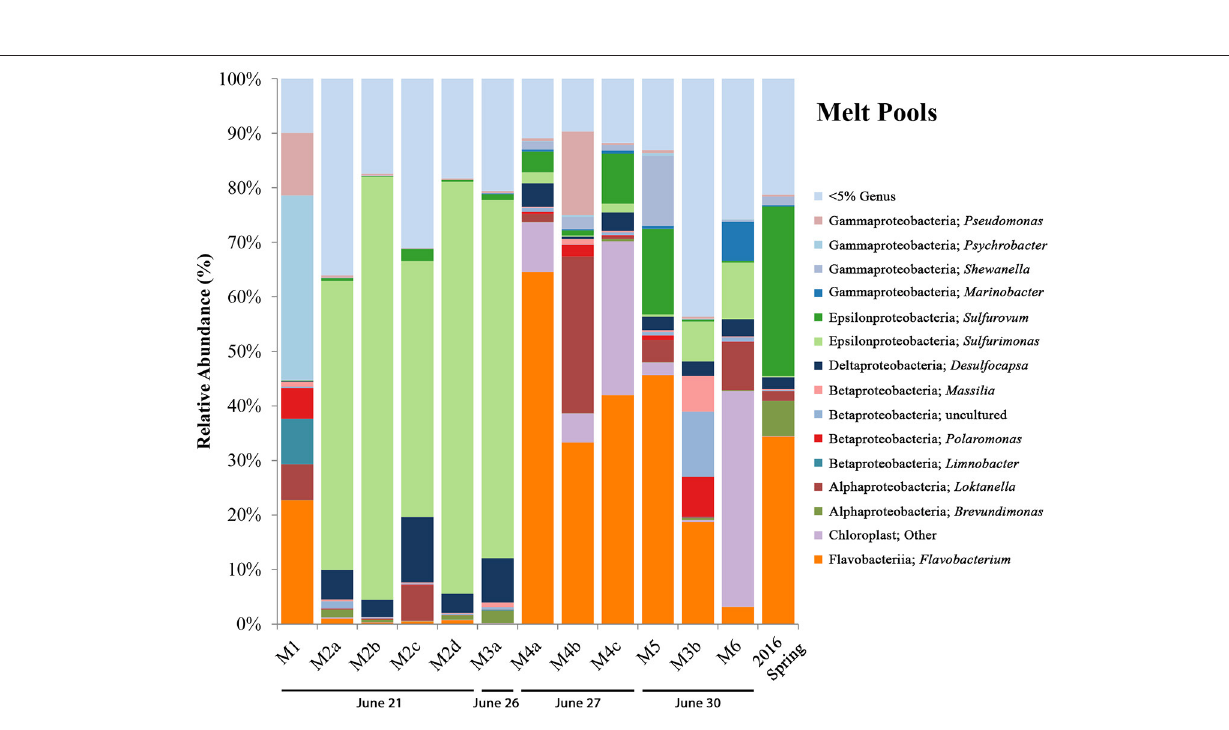
Frontiers in Microbiology | www.frontiersin.org